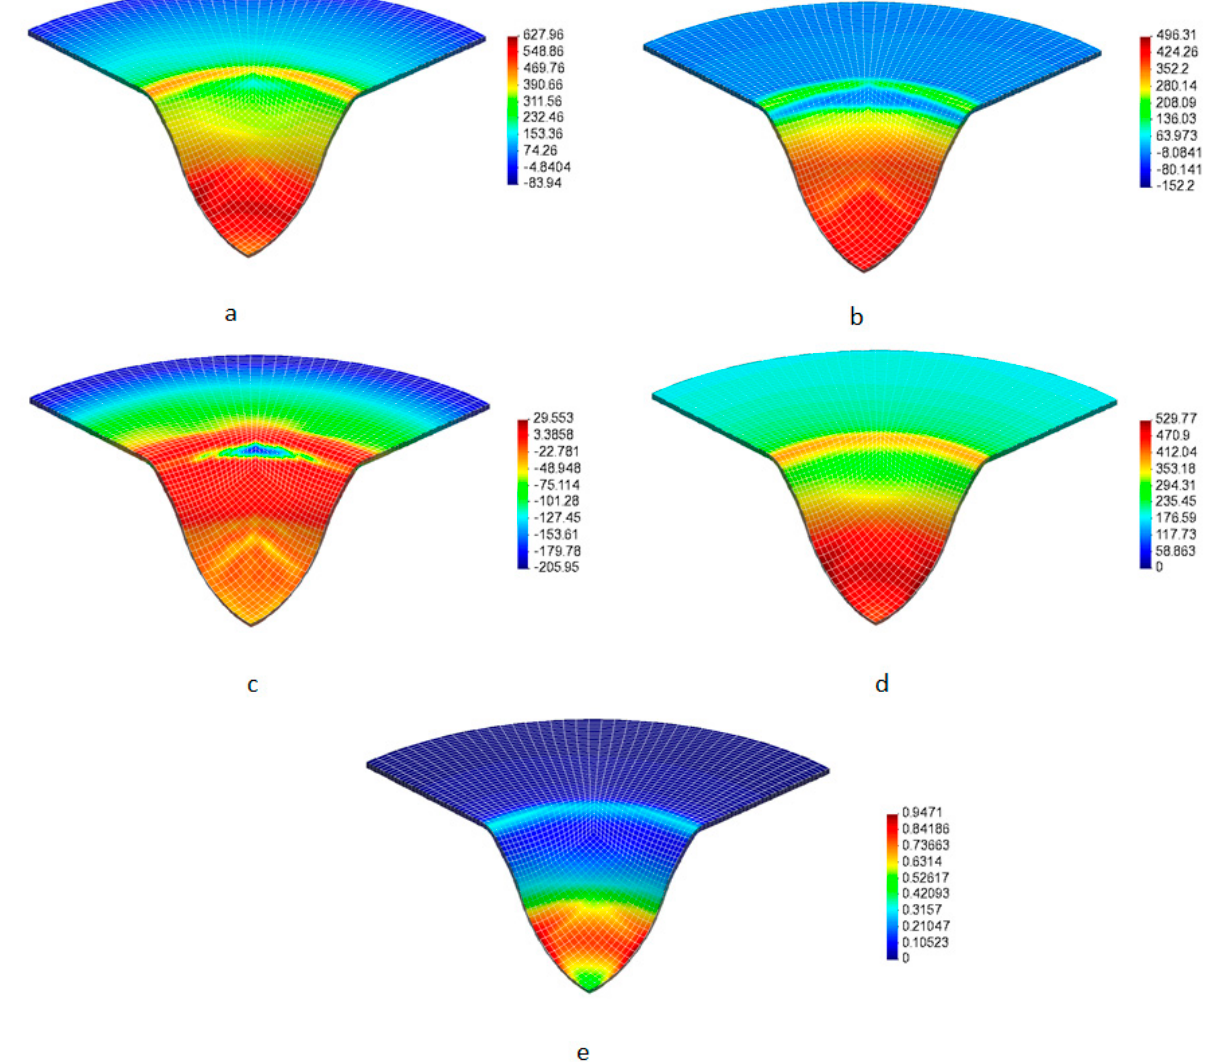
Figure 8. Erichsen test of the EK4 steel: numerical contours at the fracture stage. ( a – c ) principal stresses (in-plane σ I and σ II and out-of-plane σ III ), ( d ) equivalent stress and ( e ) effective plastic deformation. The experimental and numerical dimensionless thickness (i.e., final/initial thickness ratio) radial profiles at the final fracture stage of the sample are plotted in Figure 9. The computed results are found to adequately capture the thickness profile along the whole radius of the sample. As expected, fracture occurs at the location of maximum thickness reduction, i.e., at a radial distance of 6 mm from the center of the sample. The areas in contact and close to the punch head are highly deformed. The numerical